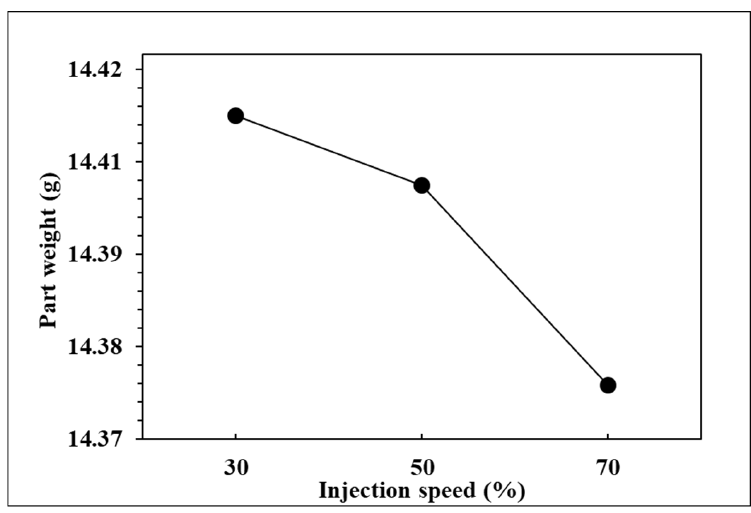
Figure 15. Relationship between timing of peak pressure and injection speed .